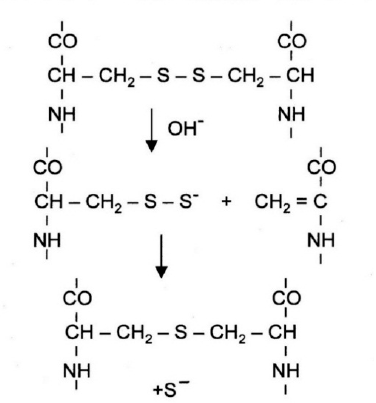
Figure 31. Alkaline degradation of Cystine [22].